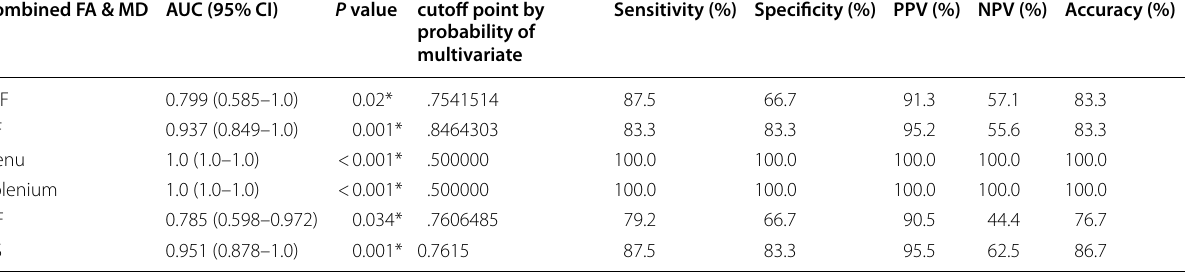
*Significance of FA alone, MD alone and combined FA and MD AUC —area under curve, PPV —positive predictive value, NPV —negative predictive value Cutoff point for saved probability by